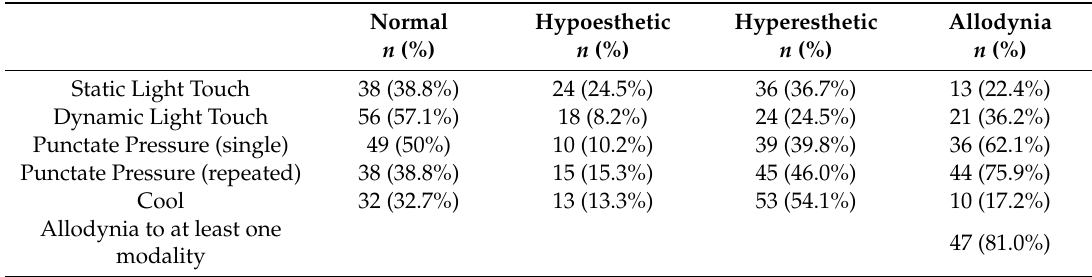
Table 3. Categorization of normal, hypoesthetic, hyperesthetic and allodynia responses to cutaneous stimuli ( n = 98). Allodynia subset ( n =